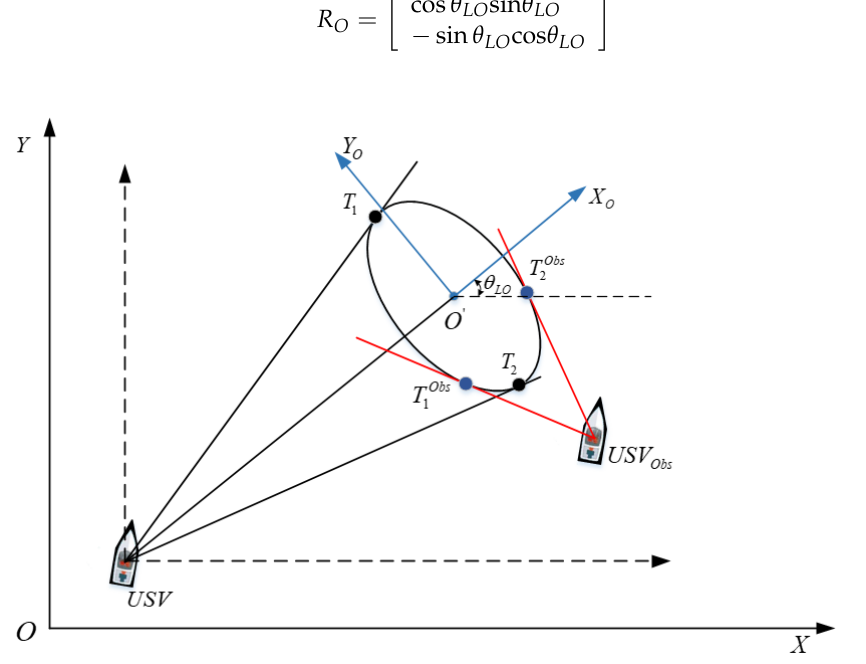
Figure 4. Tangents of ellipse